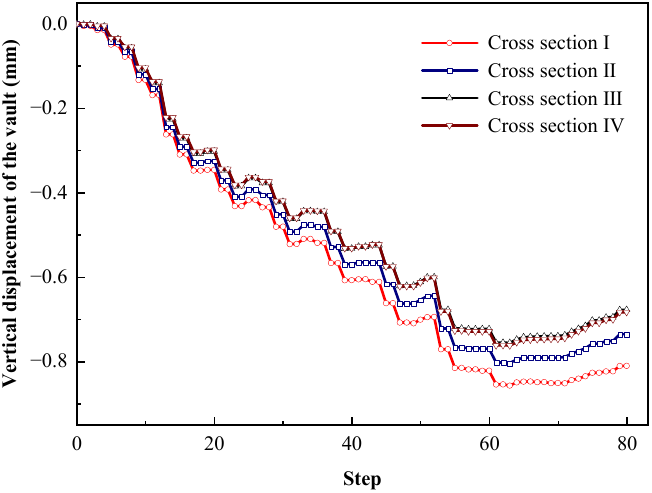
Figure 11. Vertical displacements of the vault of existed tunnel.